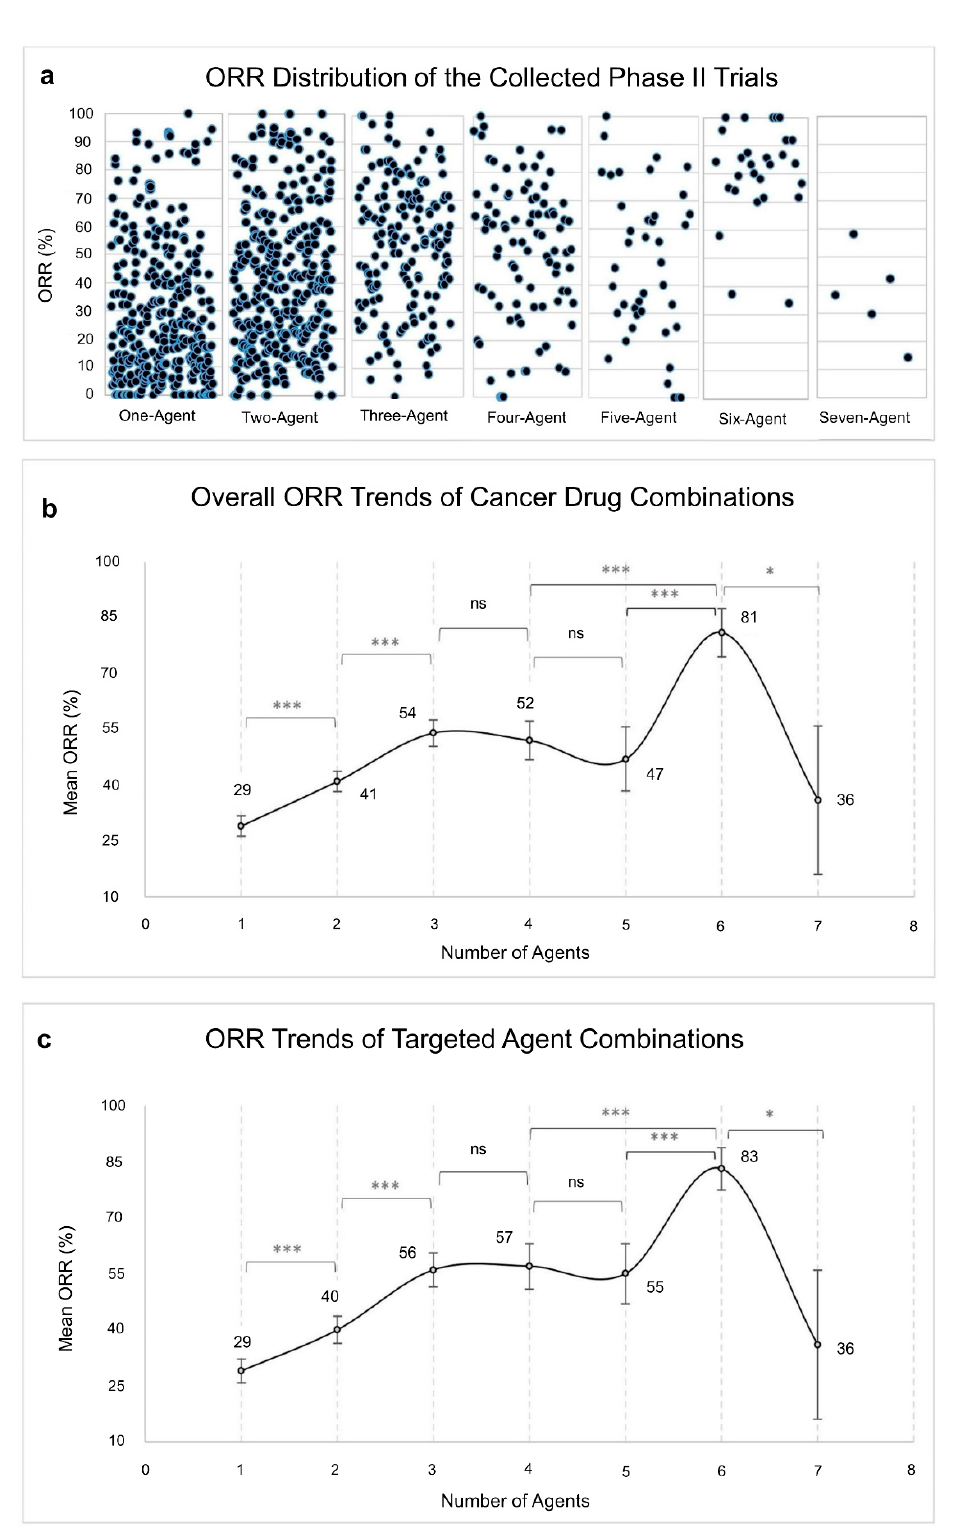
Figure 2. ORR increases with increasing number of agents in combination. ( a ), Distribution of the collected Phase II trials’ ORRs according to combination size. ( b ), ORR trends of all cancer drug combinations of the collected Phase II trials. ( c ), ORR trends of the targeted agents in combination with non-targeted agents, excluding trials with no targeted agents, n = 721. Points and error bars represent the mean ORR and 95% confidence interval, respectively. Data were analysed by two-tailed Student’s t -test with Bonferroni correction. * p < 0.007, *** p < 0.0001.